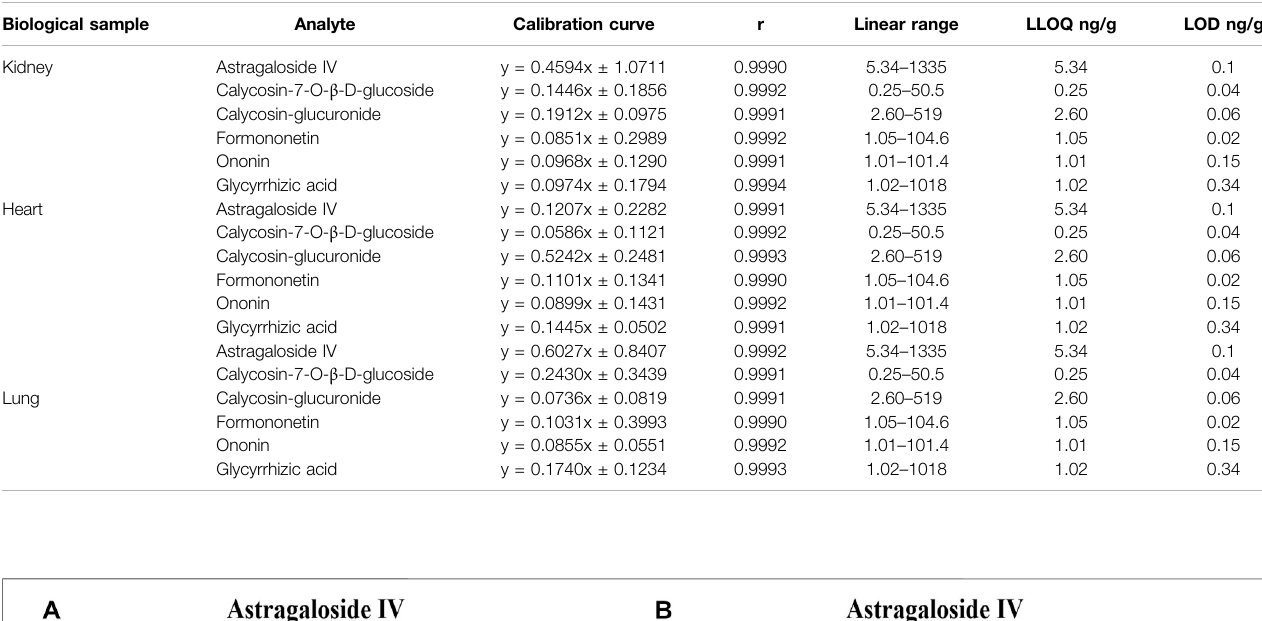
Frontiers in Pharmacology |